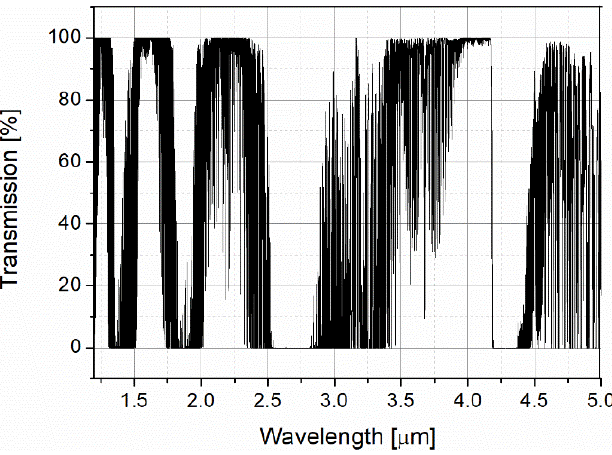
Figure 2. Atmospheric transmission at a distance of 1 km (from the HITRAN database). In a high transparent spectral range, the operation of an FSO system is limited by scattering (Rayleigh, Mie, and geometrical). To analyze this phenomenon, scattering particle size should be compared to the light wavelength (Table